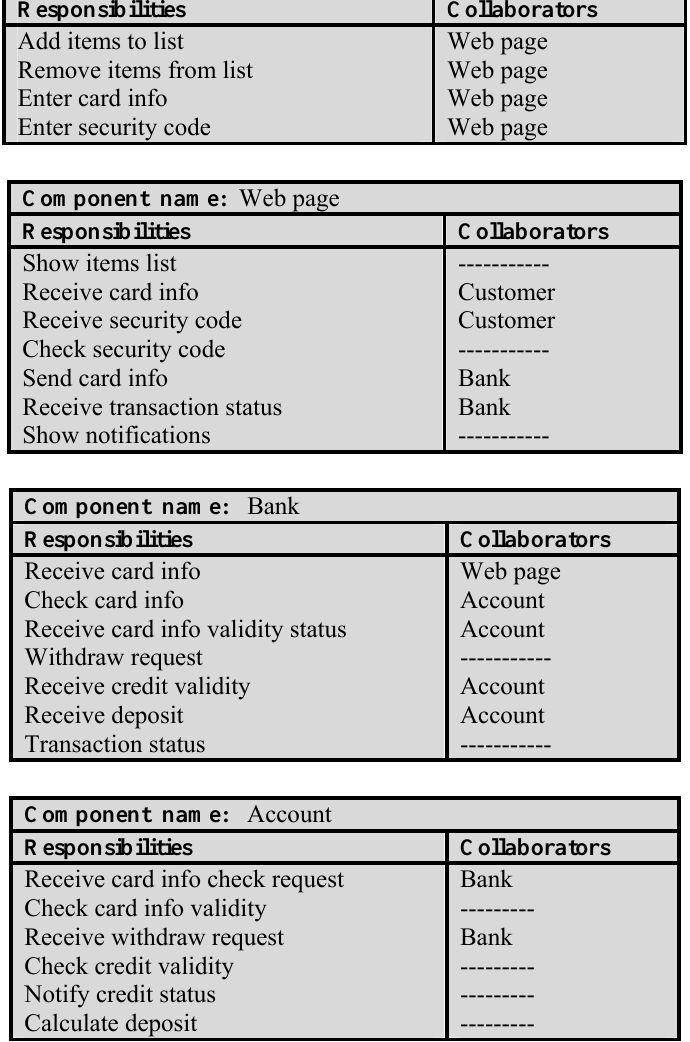
Fig. 6. The CRC cards of the online shopping